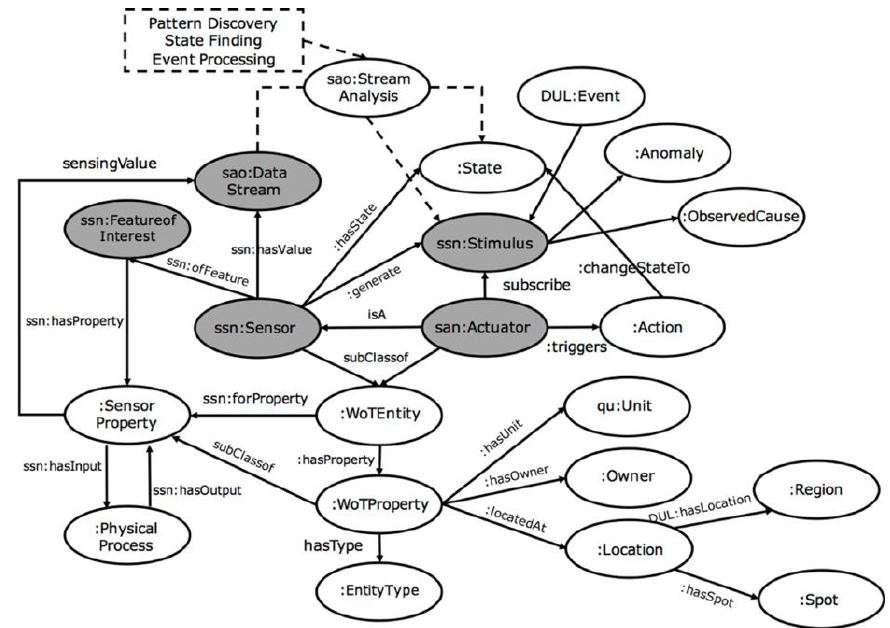
Figure 2. A reference SWoT-O ontology model by extending SSN and reusing other IoT ontologies. Default SWoT namespace have been omitted.